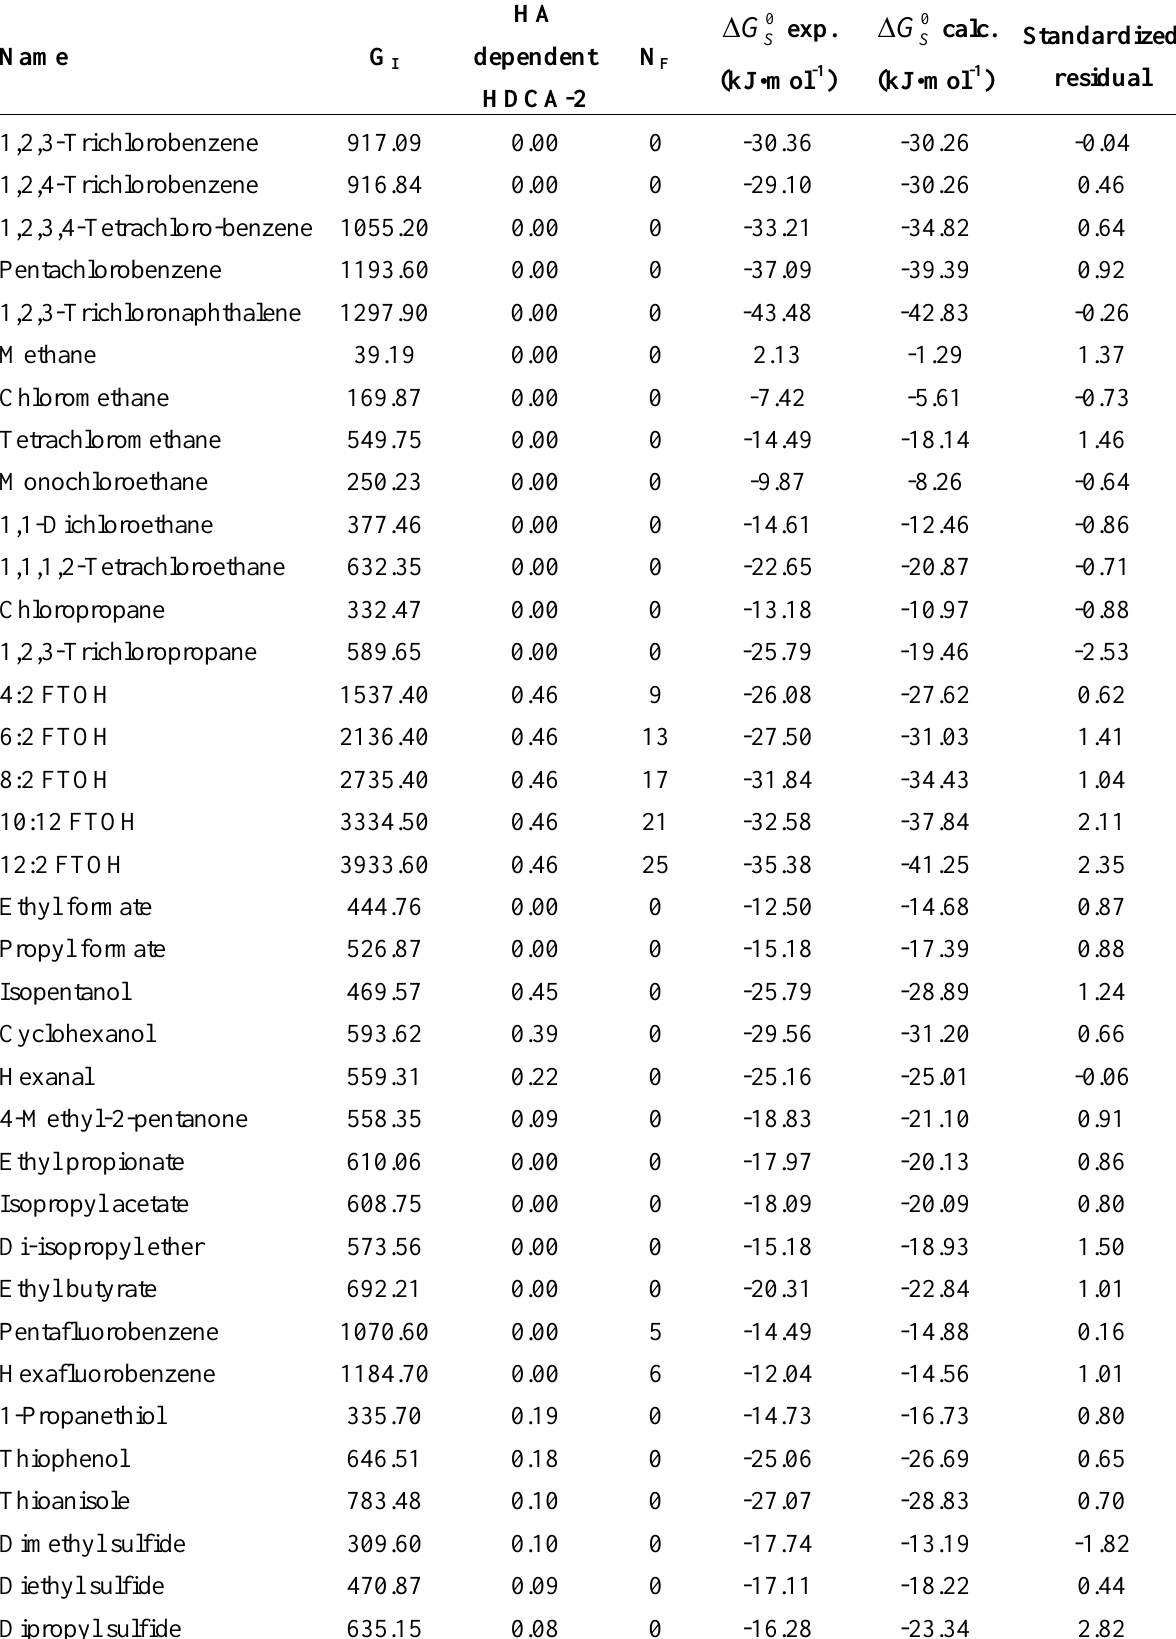
G  for the validation S